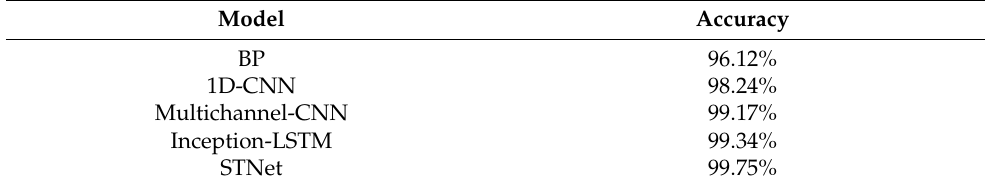
Table 5. Model comparison experiments.